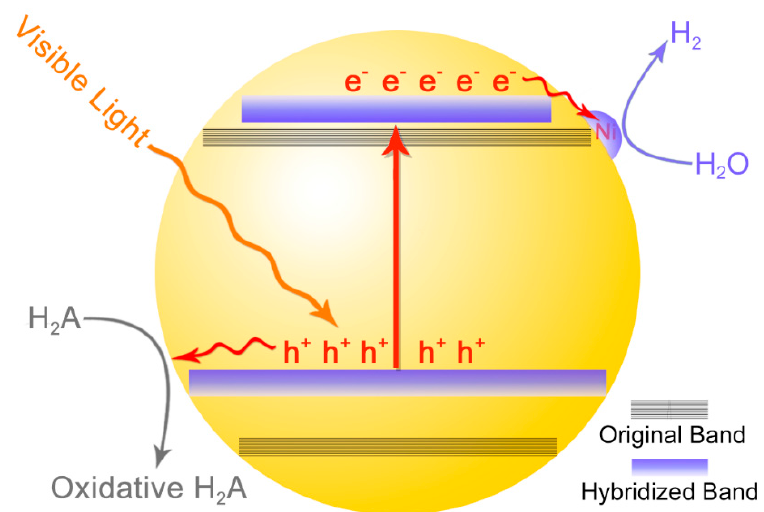
Figure 7. The transformation of conduction/valence band of In 2 S 3 QDs after the decoration of Zn and Cu, as well as the photocatalytic H 2 evolution mechanism of the Cu 0.4 -ZnIn 2 S 4 QDs.